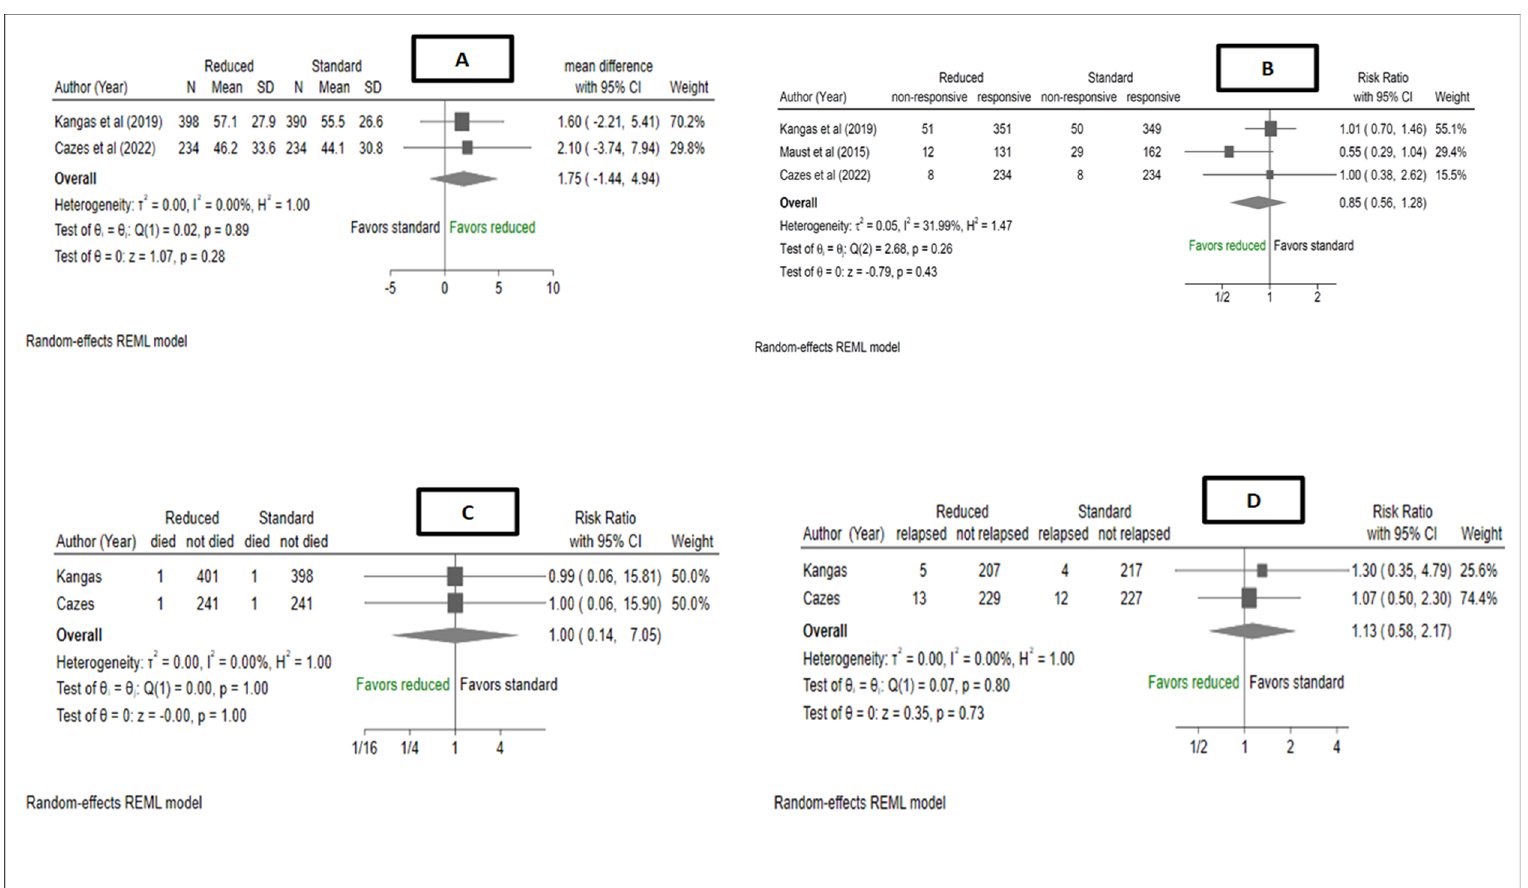
Figure 5. Forest plot of ( A ) time to recovery, ( B ) non-response rates, ( C ) mortality rates and ( D ) relapse rates from a meta-analysis of studies comparing reduced RUTF dose with standard RUTF dose for the treatment of severe wasting and/oedema. Effect estimates for Cazes et al. [14] (means and standard deviations) were obtained directly from the authors. Effect estimates for Kangas et al. [12] were computed from their open-source data. Kangas et al. [12], used length of stay, which was defined as number of days spent from admission to either recovery, referral, non-response, false discharge or last visit before defaulting. Non-response was assessed at 16 weeks in Kangas et al. [12] and 6 months in Cazes et al. [14]. Cazes et al. [14] used the time to nutritional improvement. Only ITT results were meta-analysed, for all studies.